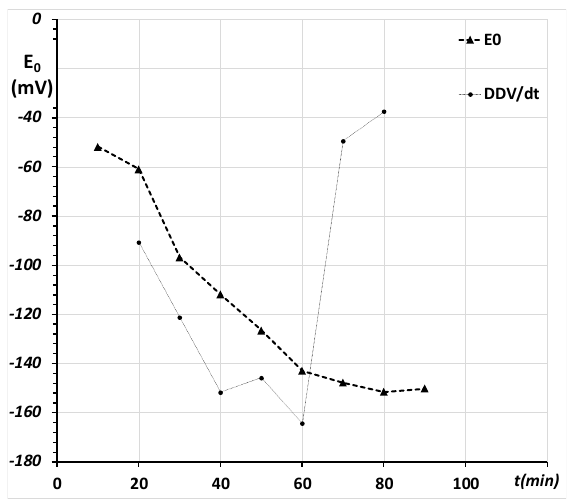
Figure A2. Calculated E 0 (thick dashed line) and its first derivative (thin line) at the different times during the recovery phase of the RBC oxidative challenge experiment.